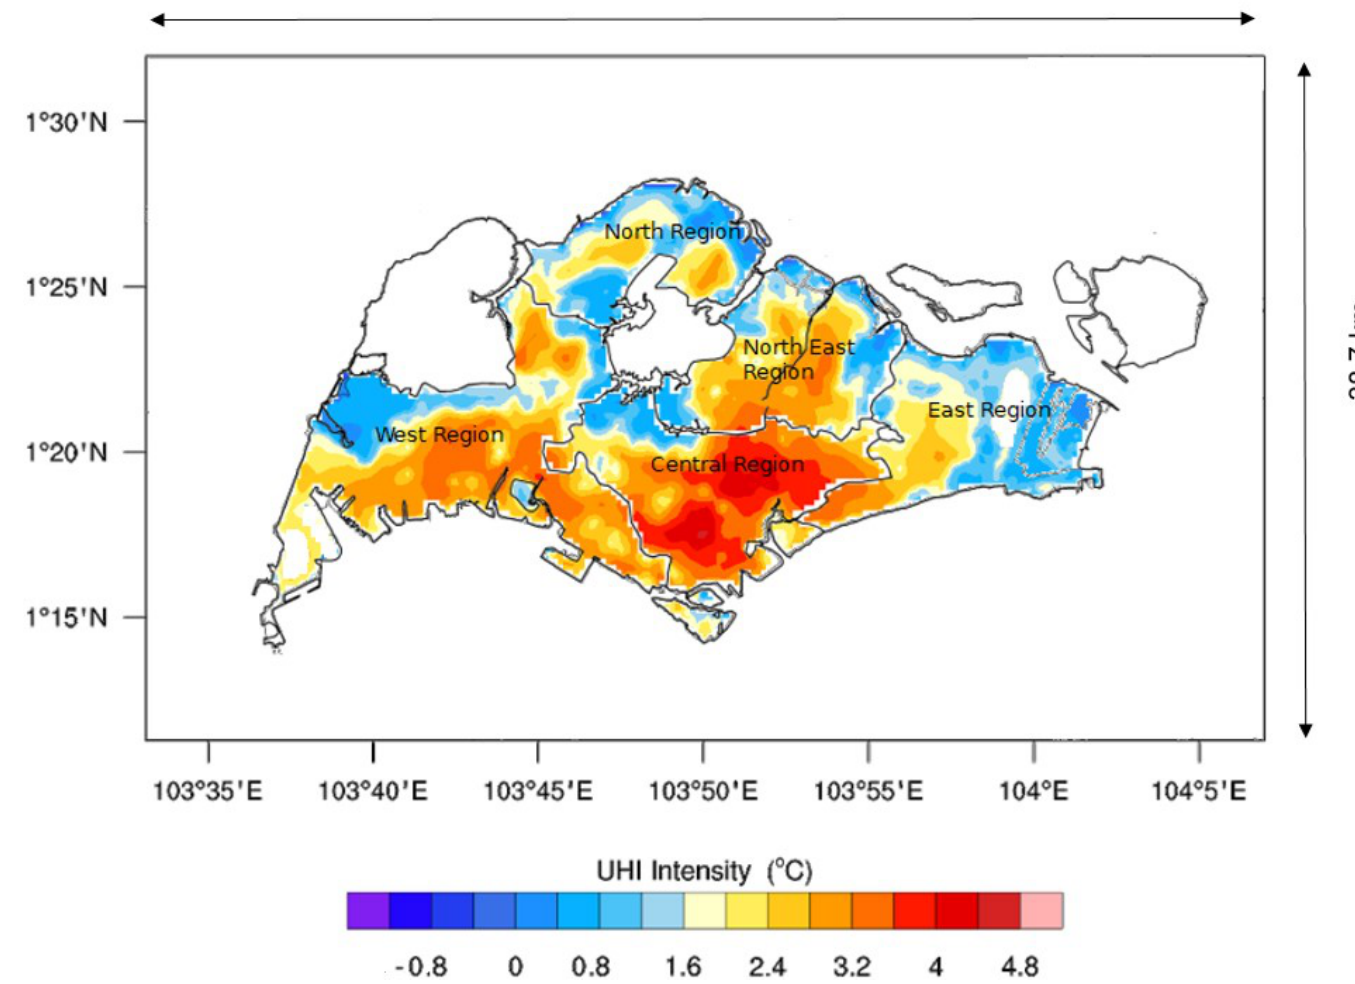
Figure 5. Spatial distribution of UHI intensities in Singapore. Data from April 2016 at 04:00